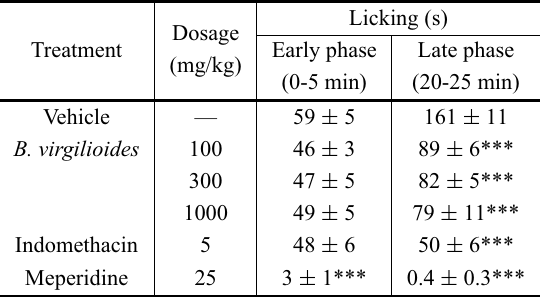
Effect of orally administered ethanolic extract of Bowdichia virgilioides on nociception induced by formalin in mice. Licking (s) Dosage Treatment